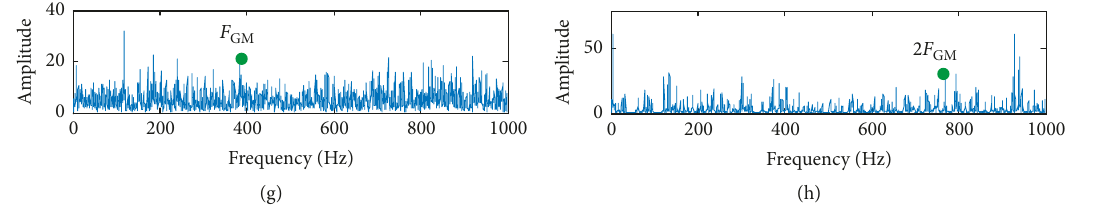
Figure 31: The frequency domain diagram of multiresolution DMD modes of the normal gear signal, where (a)–(h) are corresponding to signals in Figure 27, respectively.